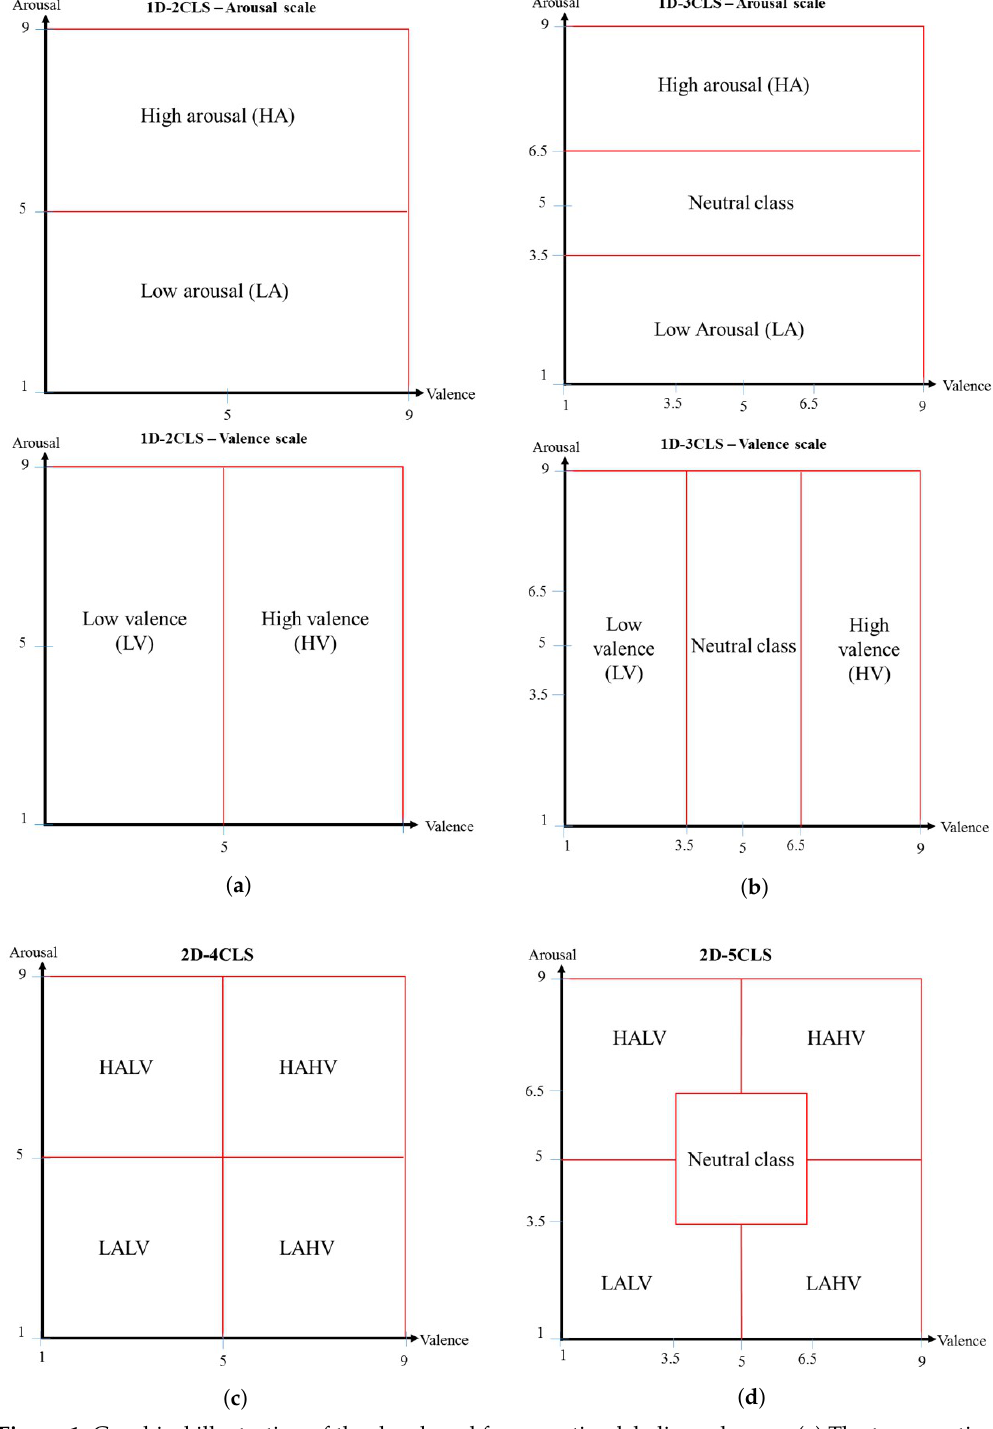
Figure 1. Graphical illustration of the developed four emotion labeling schemes. ( a ) The two emotion classes defined for the arousal scale ( top ) and valence scale ( bottom ) using the 1D-2-class labeling scheme (2CLS). ( b ) The three emotion classes defined for the arousal scale ( top ) and valence scale ( bottom ) using the 1D-3CLS. ( c ) The four emotion classes defined using the 2D-4CLS. ( d ) The five emotion classes defined using the